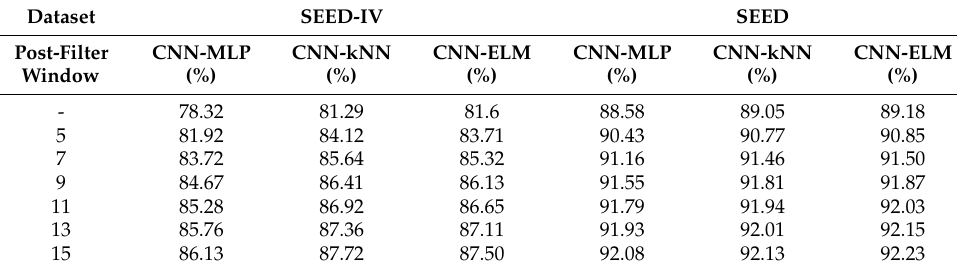
Table 6. Post-filtering results for the SEED-IV dataset.